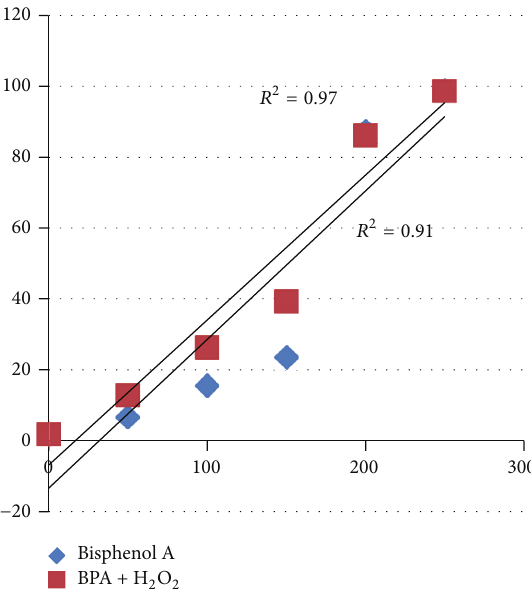
Figure 6: Hydrogen bond and steric interaction of human glu- tathione peroxidase (PDB id-2F8A) with bisphenol A. Green color is bisphenol A and whole structure is glutathione peroxidase.